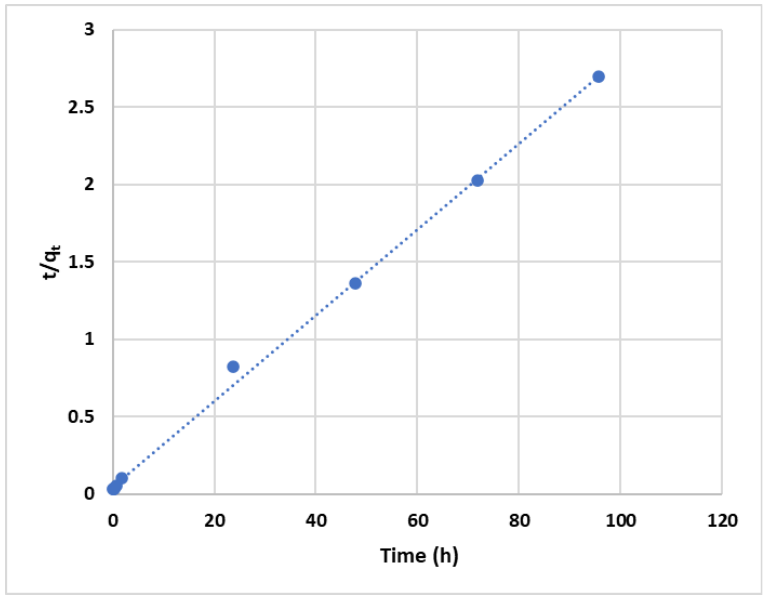
Figure 16. The model plot of pseudo-second-order for the adsorption CR dye onto 2Clph-BU-Cs adsorbent (m = 0.01 g, C 0 = 100 mg L − 1 , V = 50 mL, pH = 4, and T = 298